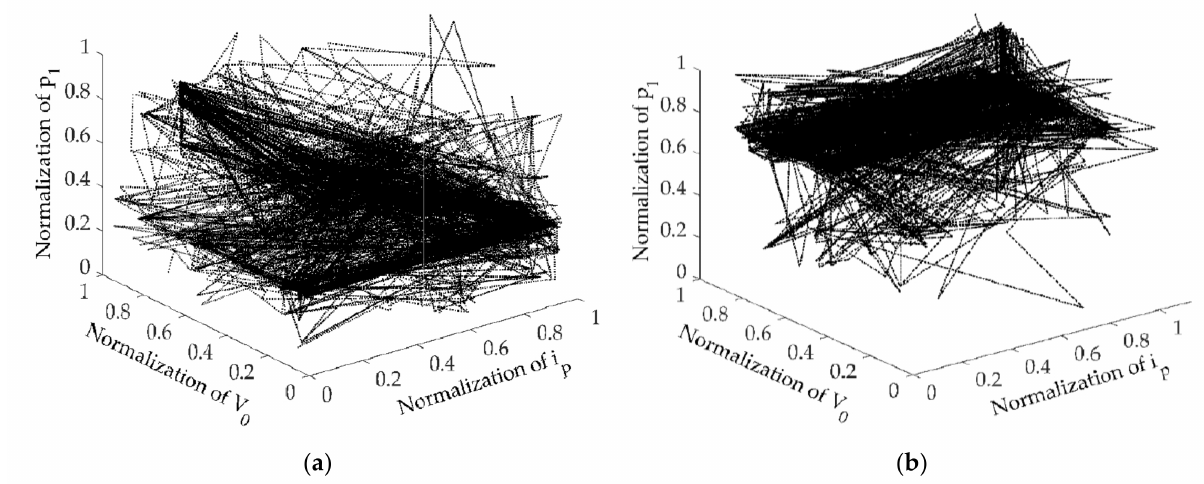
Figure 16. Variation of design variables. ( a ) VDPM displacement is 180 mL/r; ( b ) VDPM displacement is 125 mL/r.